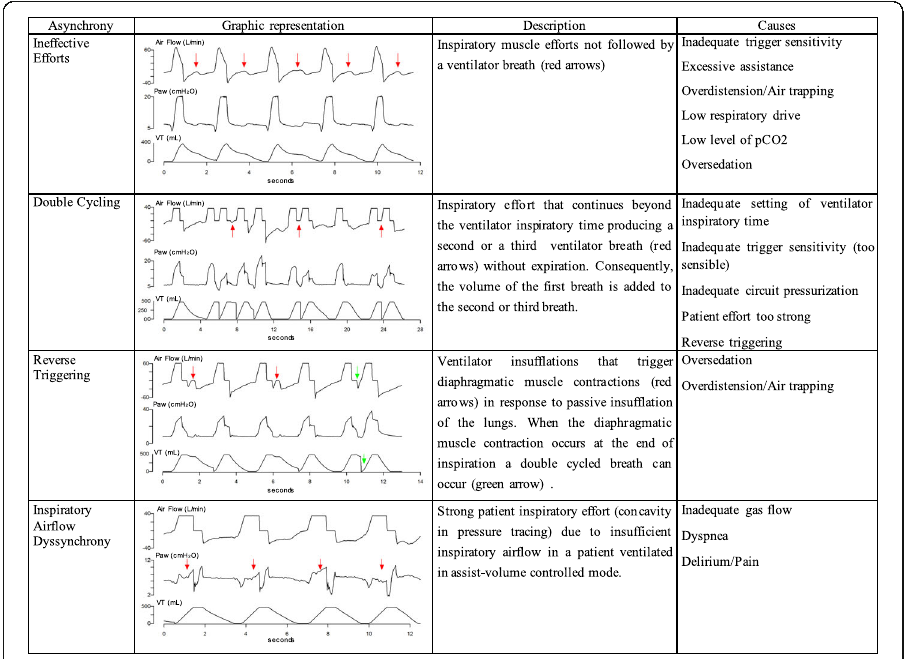
Fig. 1 Representation and description of the most common asynchronies. Ineffective efforts, double cycling, reverse triggering, and inspiratory airflow dyssynchrony are graphically represented and described together with their causes. Red arrows indicate where the asynchrony described is